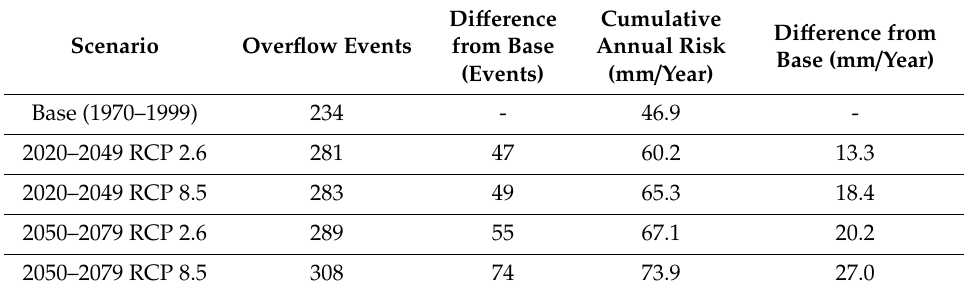
Table 4. A comparison of overflow events and cumulative annual risk for the treatment train under baseline and climate change scenarios. Scenario Overflow Events